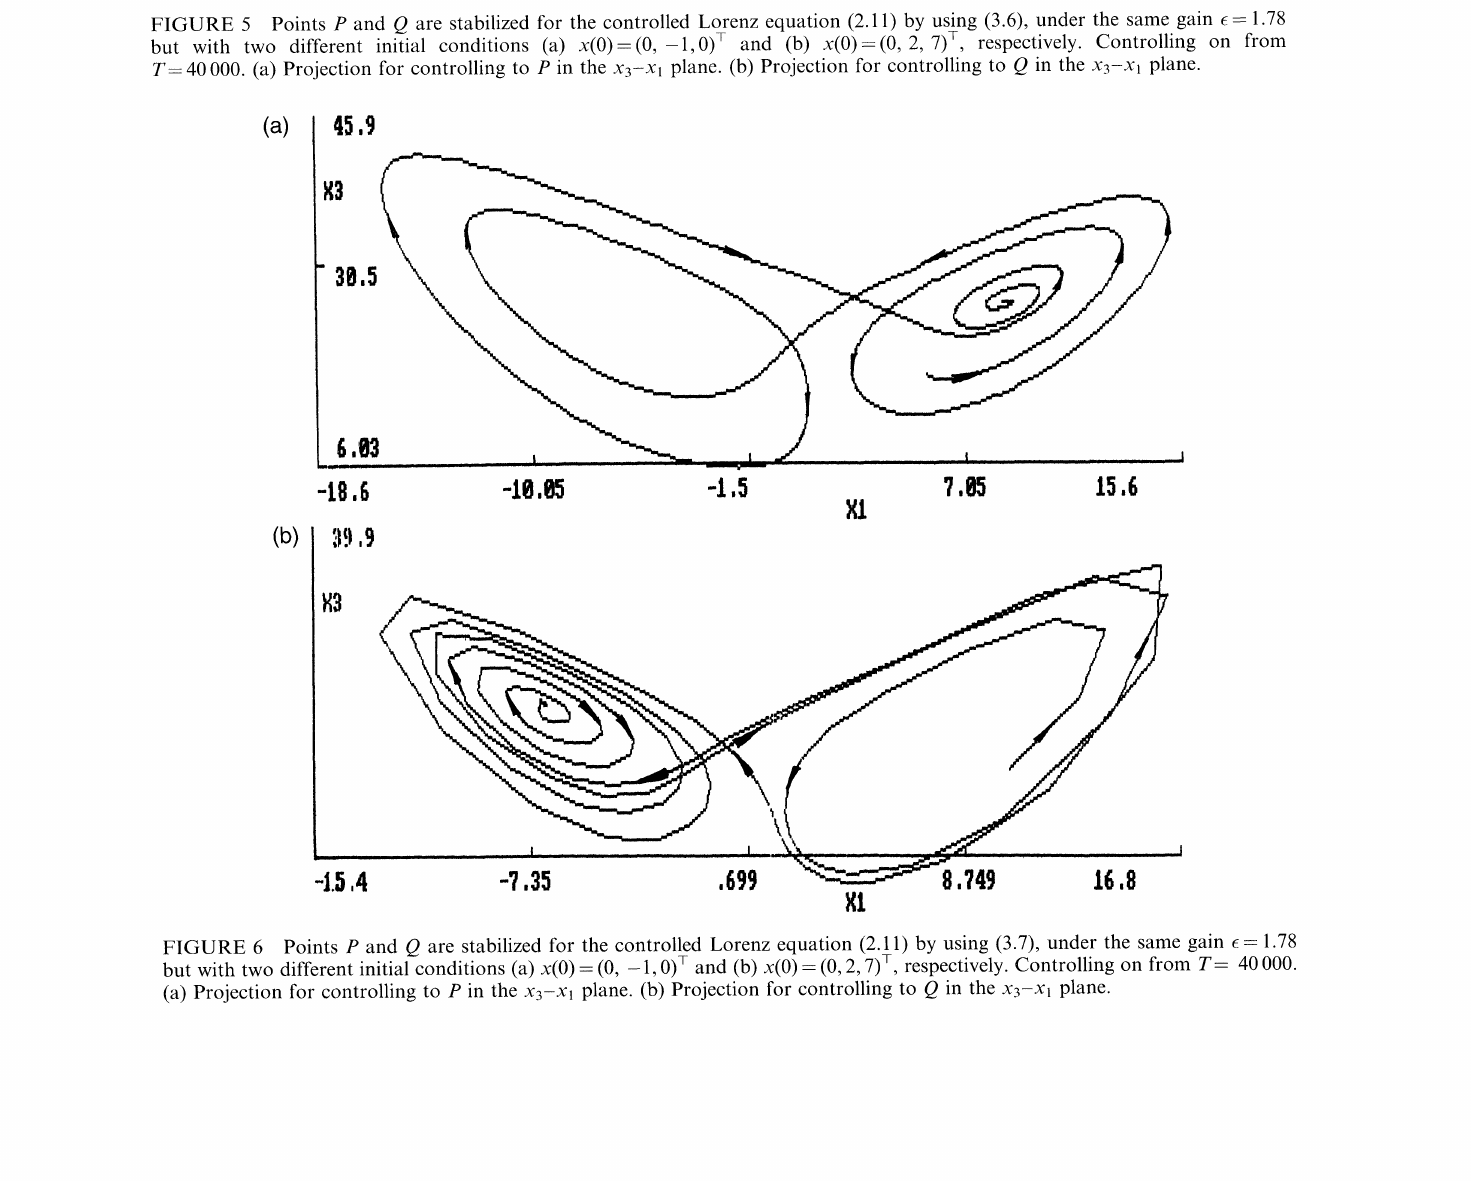
- - 1.78 v, respectively. Controlling on from T= 40000. and (b) x(0)= (0, 2, 7)